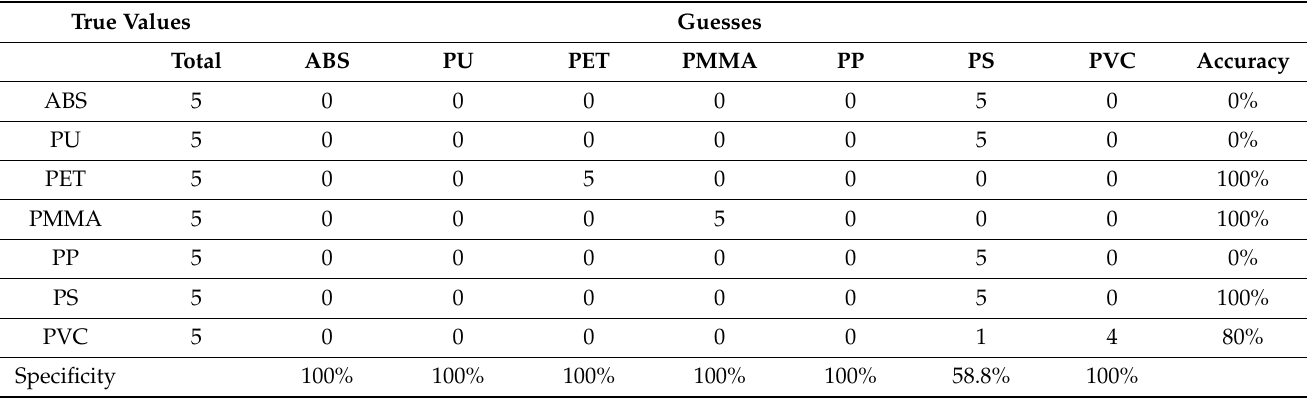
Table 3. Confusion matrix of the test data recorded with ambient noise with calculated accuracy (sensitivity) and specificity of each material, when pulse salvo classification is used.